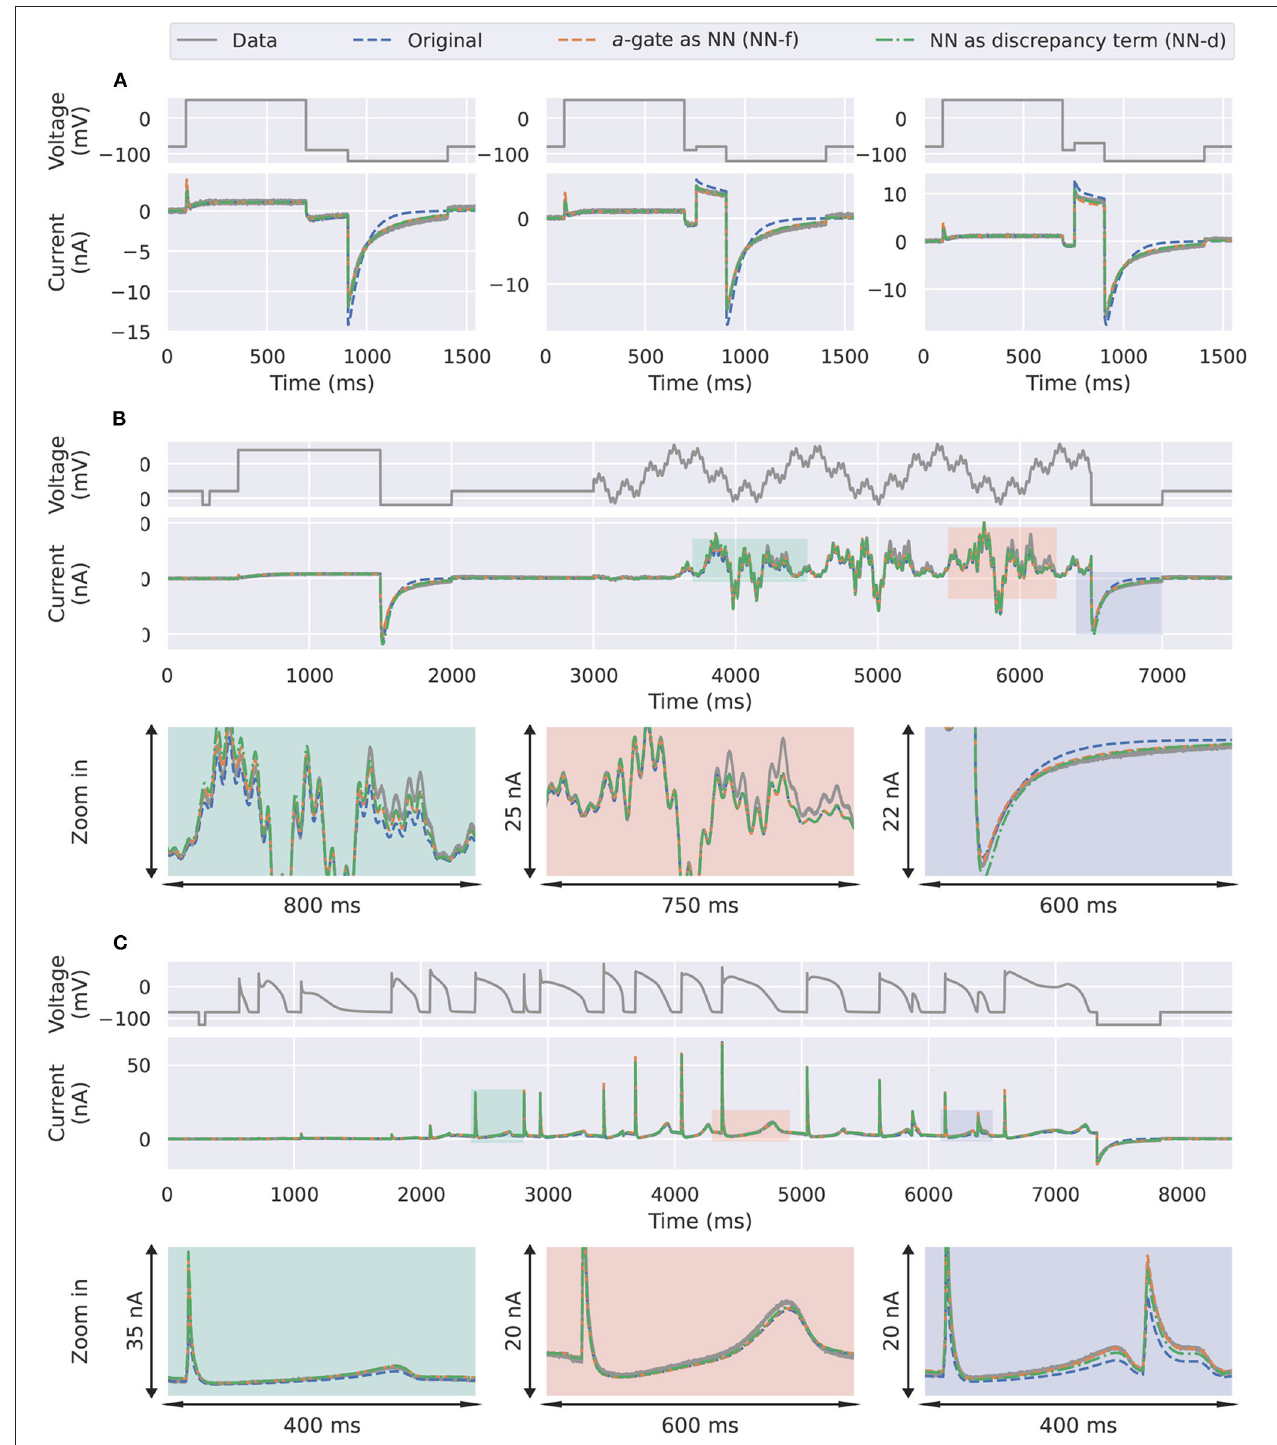
FIGURE 4 | Prediction results for the synthetic data studies. Comparison of the synthetic data generated using the ground truth model (grey) against the candidate a -gate model (blue), the a -gate modelled using a neural network (NN-f, orange), and the a -gate with a neural network discrepancy term (NN-d, green). (A) Shows a part of the inactivation protocol (Pr4), showing the first three steps of the protocol. (B) Shows the sinusoidal protocol. (C) Shows a protocol consists of a series of action potentials. All figures with a blue background are synthetic data examples.